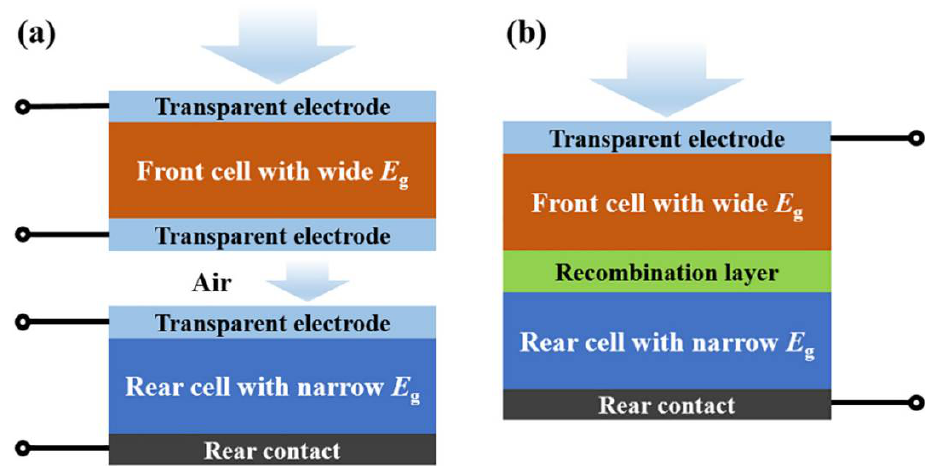
Figure 2. ( a ) Schematic of tandem solar cell with four-port structure, ( b ) Schematic of tandem solar cell with two-port structure [21].